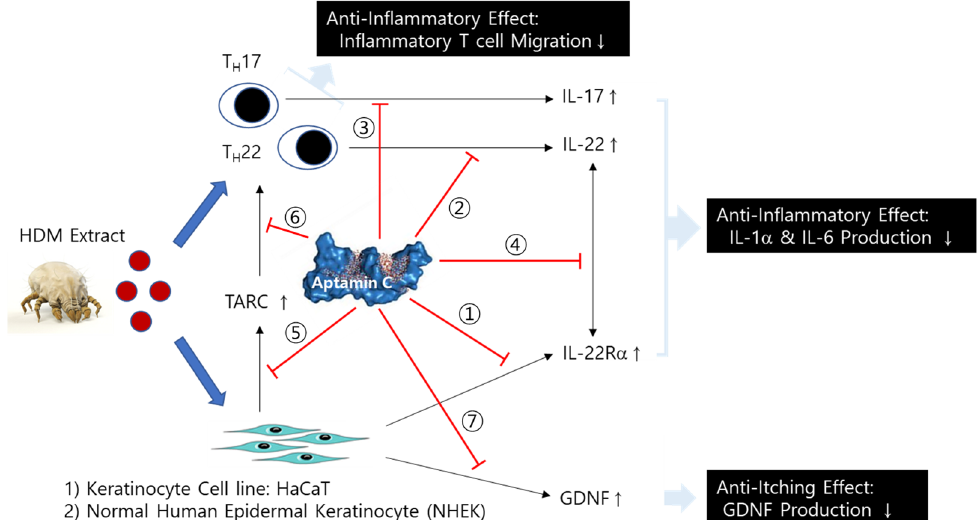
Figure 6. Mechanism of the anti-inflammatory and anti-itching effect of Aptamin C on skin inflam- mation by HDM. Aptamin C shows an anti-inflammatory effect by the suppression of ① IL-22R α expression on HaCaT, ② IL-22 production from T cells, ③ IL-17 production from T cells, ④ the interaction between IL-22 and IL-22R α , ⑤ TARC production via the interaction between IL-22 and IL-22R α , and ⑥ TARC-induced T cell migration, as well as an anti-itching effect by the suppression of ⑦ GDNF production from HaCaT and primary keratinocytes. Supplementary Materials: The following are available online at https://www.mdpi.com/article/ 10.3390/antiox10060945/s1, Supplementary Figure S1. Effects of HDM extract on proliferation of HaCaT. Supplementary Table S1. Gene expression profiling. The table and heatmap display individual differentially expressed genes, and the table depicts a subset of the genes with the largest mean Log 2 fold-changes when comparing HDM-treated and control samples.